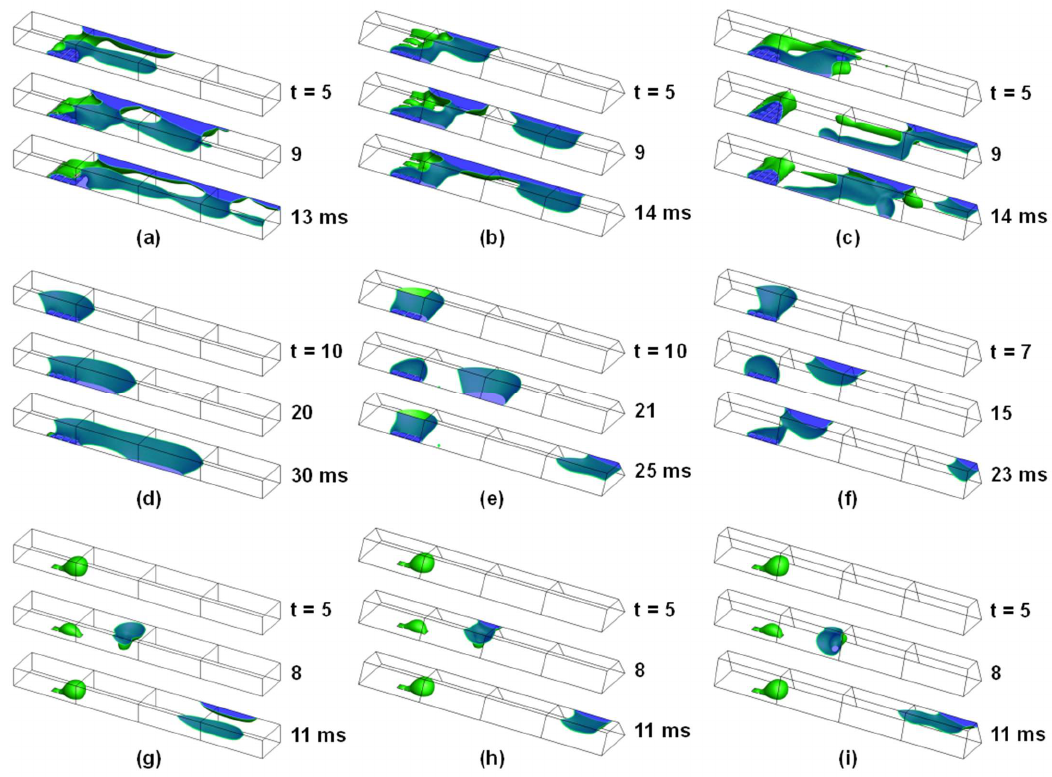
Figure 5 Figure 5. Time evolution of the gas-liquid interface in the GCs ( V in , air = 5.0 m · s − 1 , V in , water = 0.1 m · s − 1 , θ ts = 60 ◦ , θ g = 140 ◦ ): ( a ) REC (H1234); ( b ) T60 (H1234); ( c ) T72 (H1234); ( d ) REC (V1); ( e ) T60 (V1);